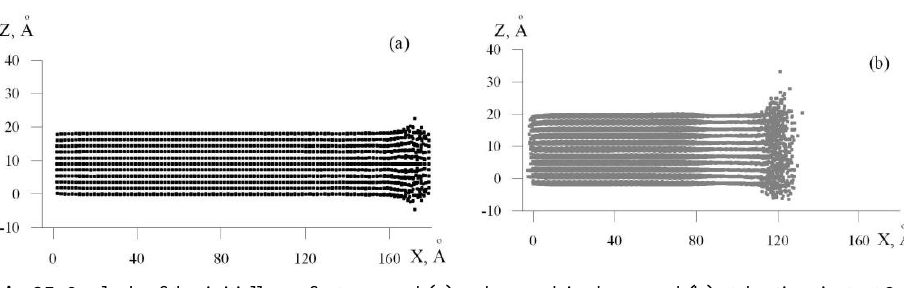
Fig. 25. Outlook of the initially perfect nanorod (а) and amorphized nanorod (b) at the time instant 2 ps after the cyclic loading start (  x 0 = 0.5 Å,  =10